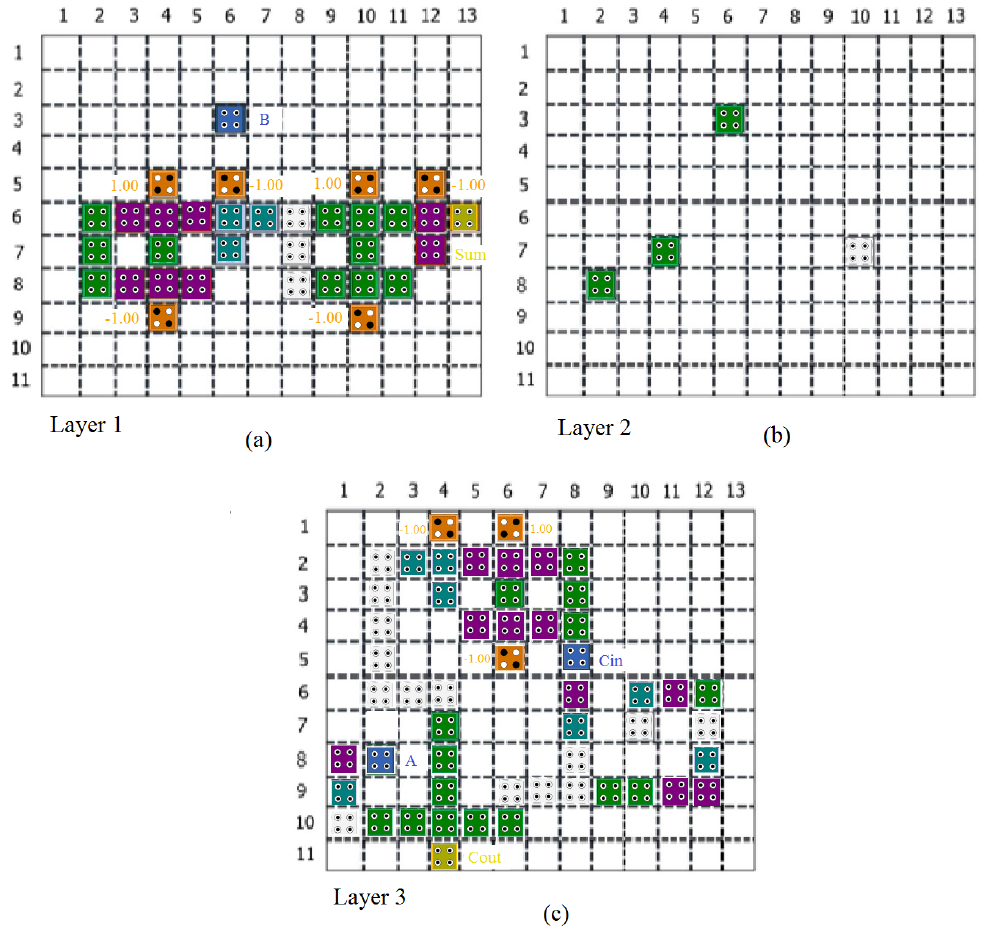
Figure 6. Full Adder/Full Subtractor circuit [13].